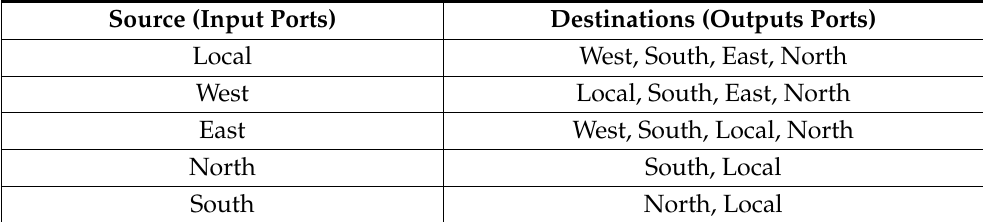
Table 1. XY Routing valid source and destinations.